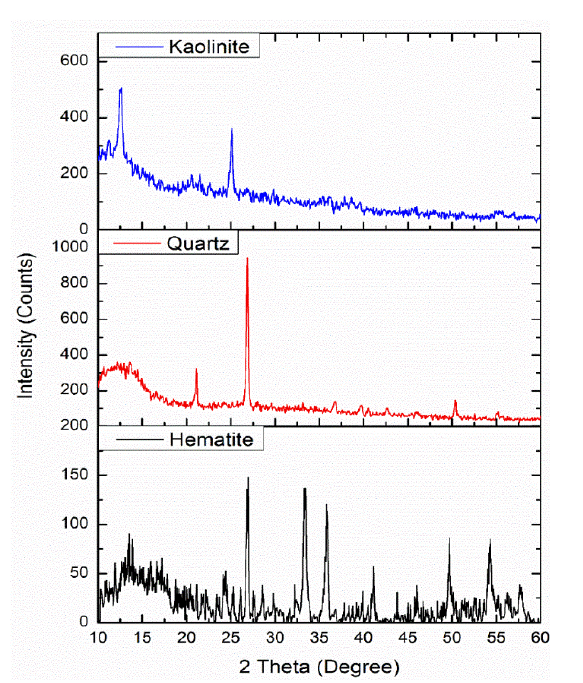
Fig. 2: XRD Analysis of Hematite, Quartz and